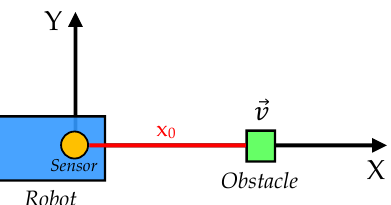
Figure 1. General obstacle tracking problem addressed in this work. Here, x 0 represents the initial distance to the obstacle, which moves at a constant speed (cid:126) v in the positive sense of the X axis.